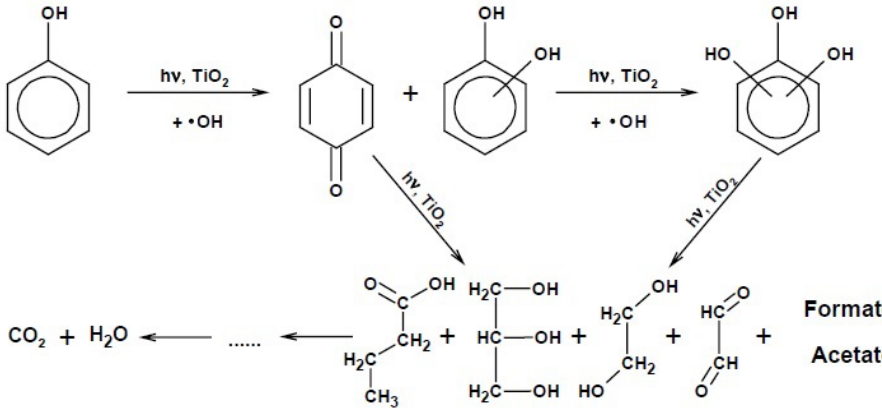
Figure 9. Possible mechanism of the phenol mineralization in the presence of TiO 2 under UV-light irradiation. Reproduced with permission from ref. [73]. Copyright 2004 Elsevier.